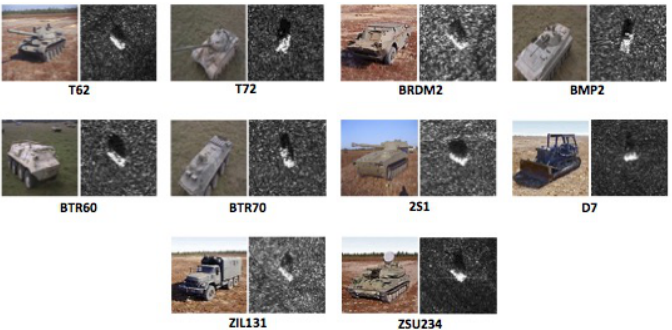
Figure 7. Ten classes of MSTAR database: two tanks (T62 and T72), four armored personnel carriers (BRDM2, BMP2, BTR60 and BTR70), a rocket launcher (2S1), a bulldozer (D7), a truck (ZIL131), and an Air Defence Unit